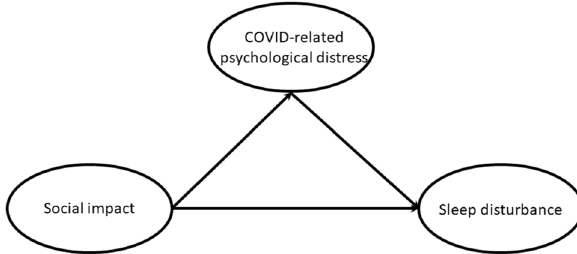
Figure 2. Conceptual model of the mediating